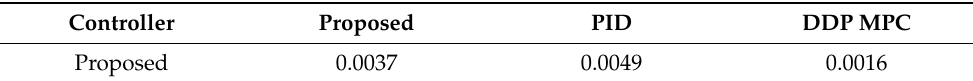
Figure 10. The control actions of different controllers. Table 3. Comparison of the state error of different